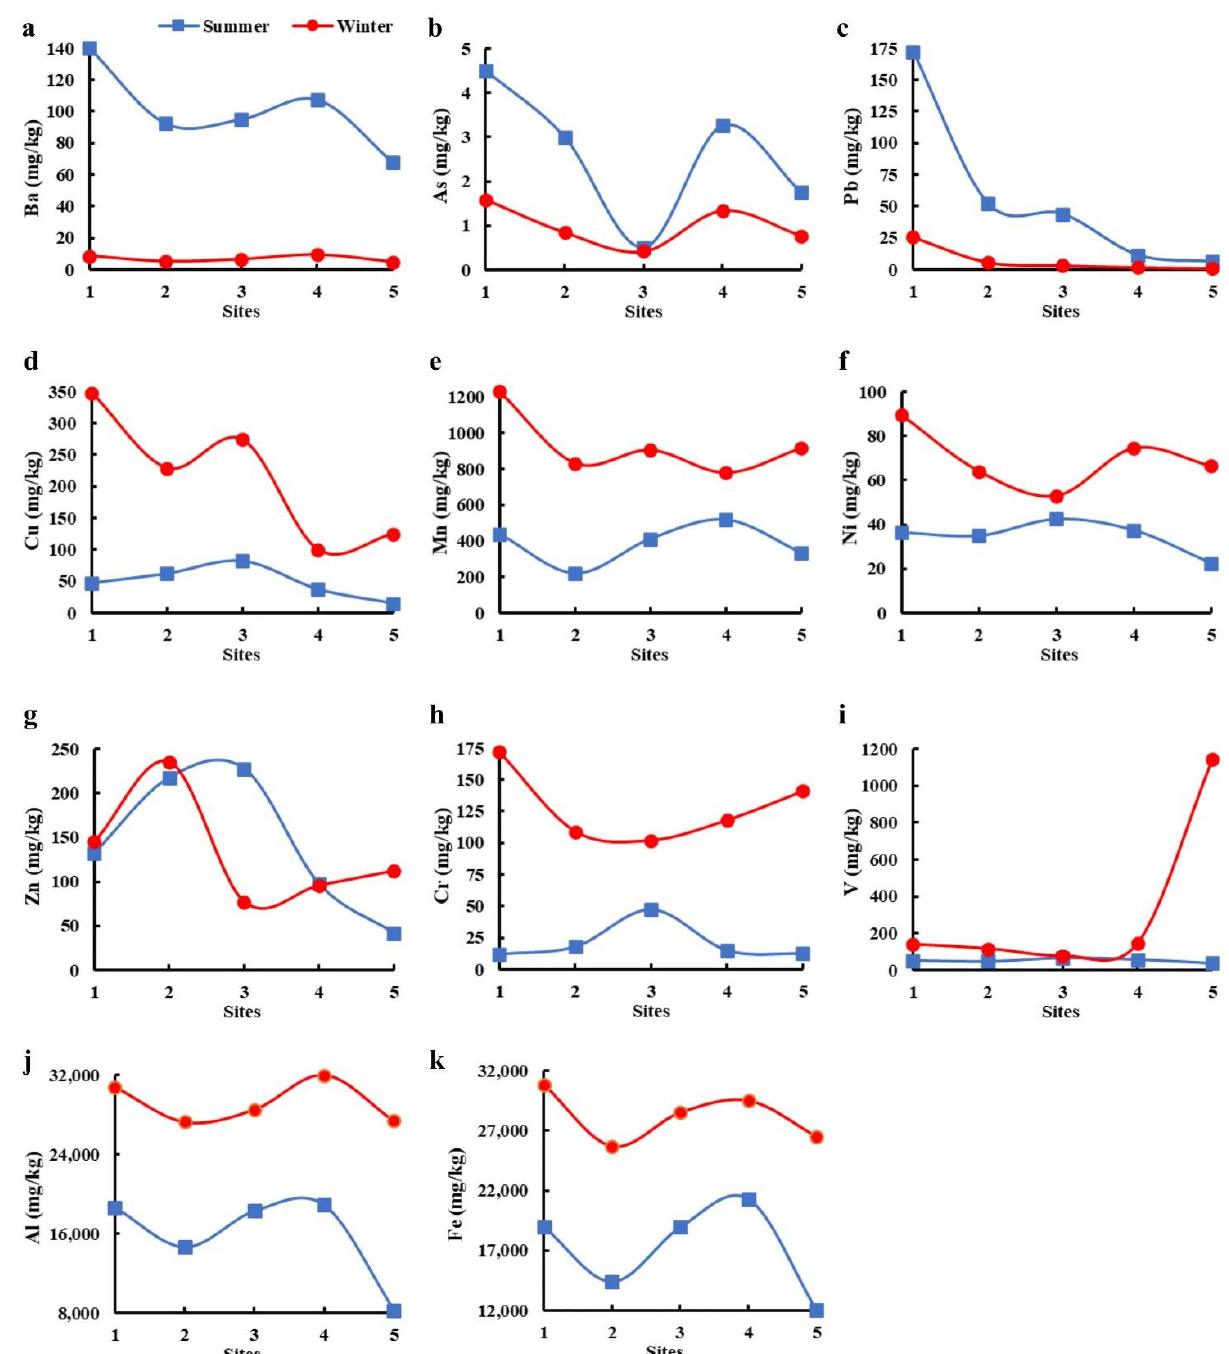
Figure 3. Spatiotemporal distribution plots of total contents of heavy metals (mg/kg) in Bahr El-Baqar drain sediments during summer and winter of 2018: Ba ( a ), As ( b ), Pb ( c ), Cu ( d ), Mn ( e ), Ni ( f ), Zn ( g ), Cr ( h ), V ( i ), Al ( j ) and Fe ( k ) collected in summer and winter of